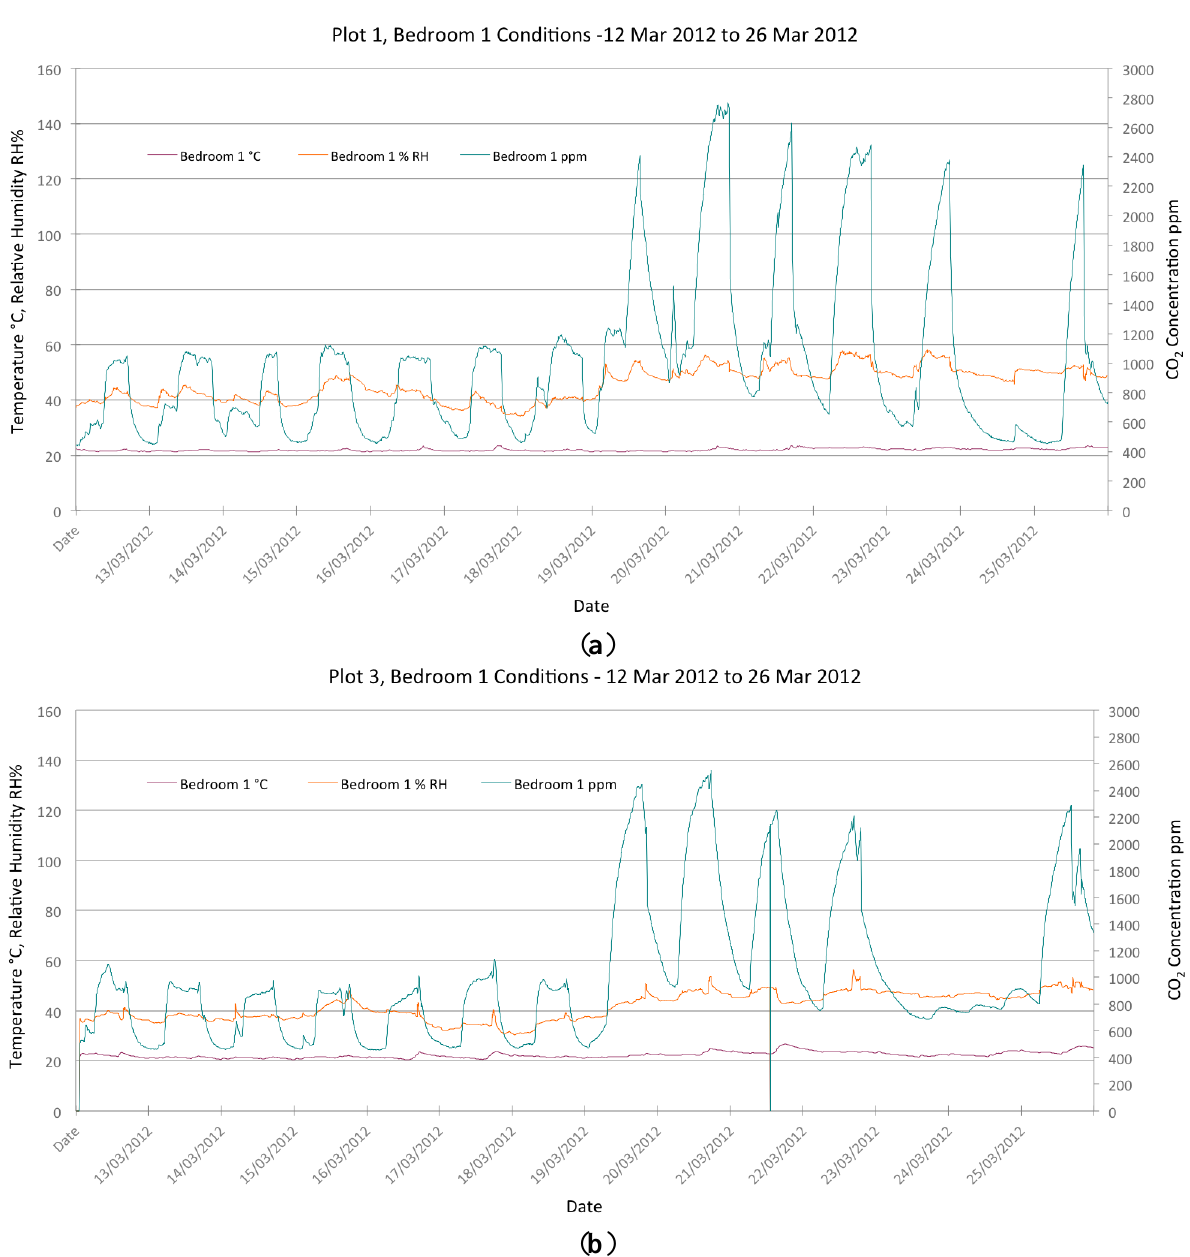
Figure 7. ( a ) CO 2 temp and RH levels SC2, Plot 1, Bedroom 1; ( b ) CO 2 temp and RH levels SC2, Plot 3, Bedroom